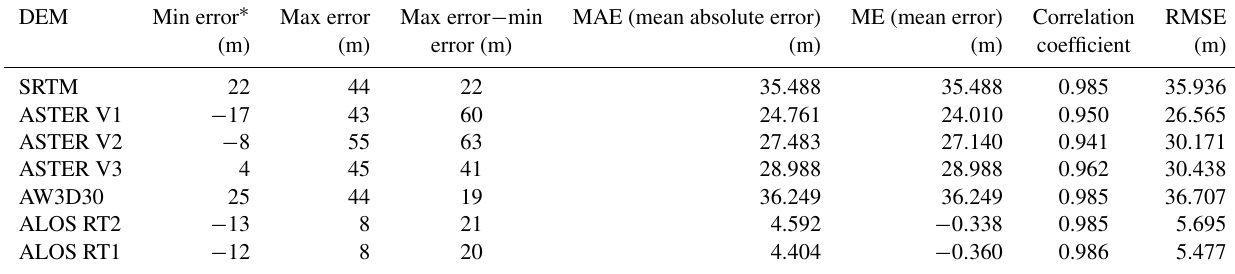
Table A1. Statistical analysis of seven DEMs in the study area.